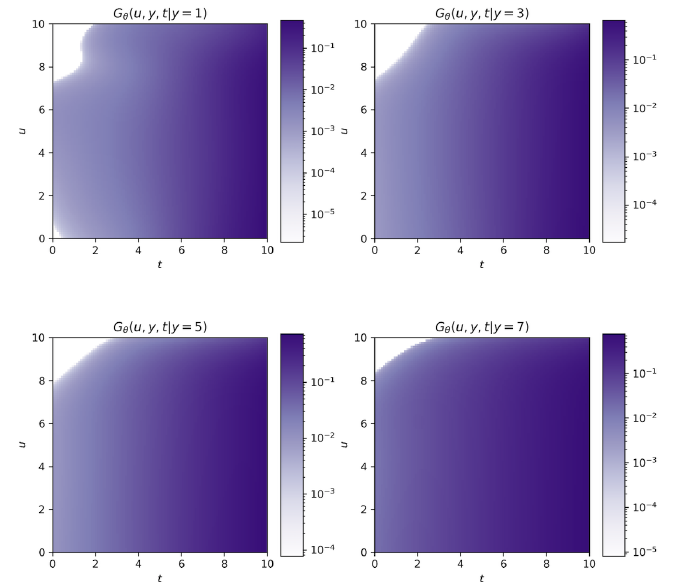
Figure 9. The values of G θ ( u , y , t ) for a fixed y (exponential distribution).